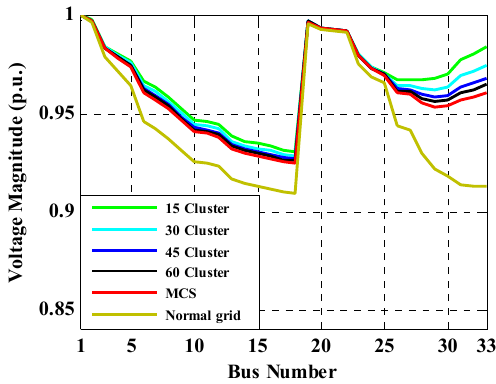
Figure 9. Voltage profile with the proposed data clustering-based direct PLF with different number of clusters (33-bus system).